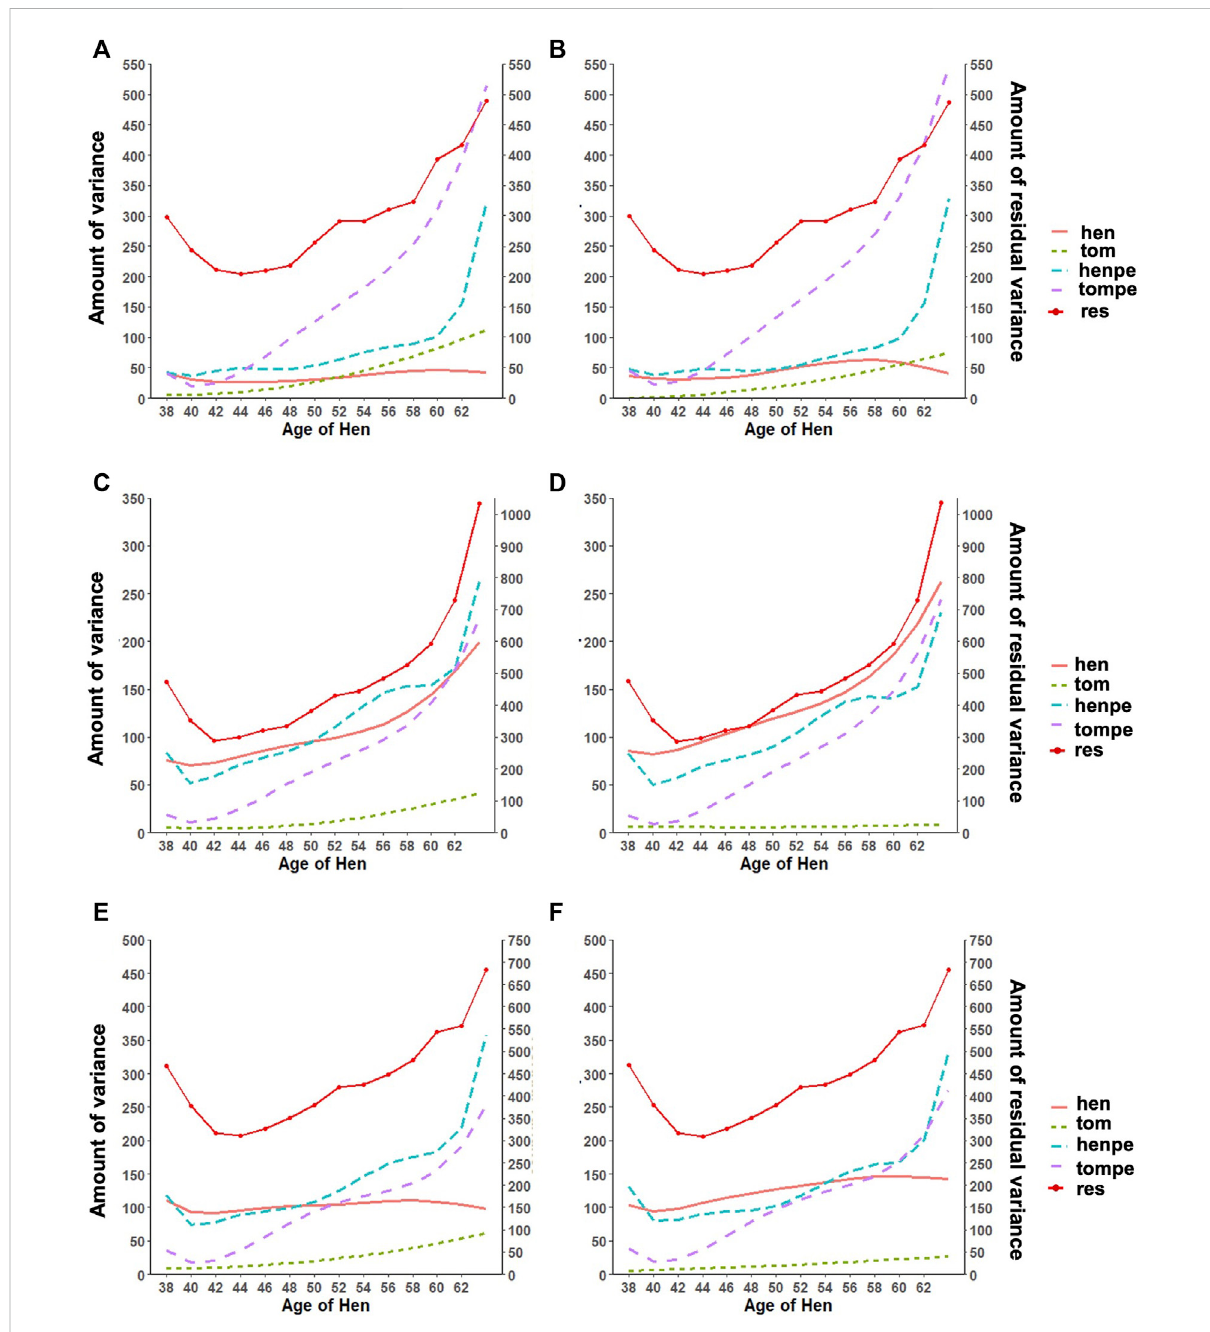
FIGURE 2 Estimates of variance components for (A) fertility (FERT) with pedigree, (B) FERT with genotypes, (C) hatch of fertile (HOF) with pedigree, (D) HOFwithssGBLUP, (E) hatchofset(HOS)withpedigree,and (F) HOSwithssGBLUPfromtherandomregressionmodelwithlinearregressionforthe additive genetic varianceofthe hen (hen) and tom (tom), the permanent environmentvariance ofthe hen (henpe) and tom (tompe), and theresidual variance